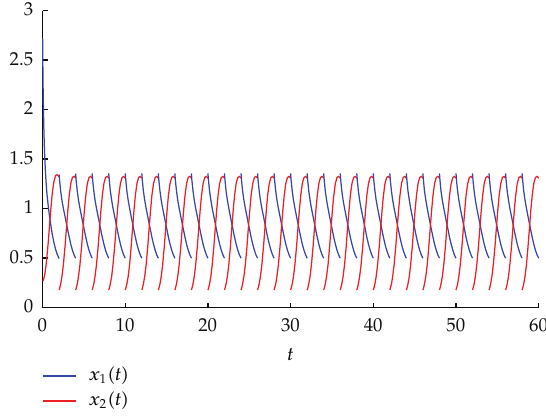
Figure 1: Time series of x 1 (cid:4) t (cid:5) and x 2 (cid:4) t (cid:5)